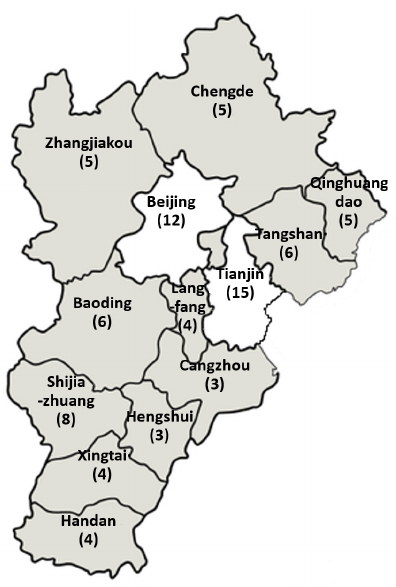
Figure 2. Locations of cities in Beijing–Tianjin–Hebei region. The numbers of national monitoring stations in 2016 in each city are listed in the brackets.